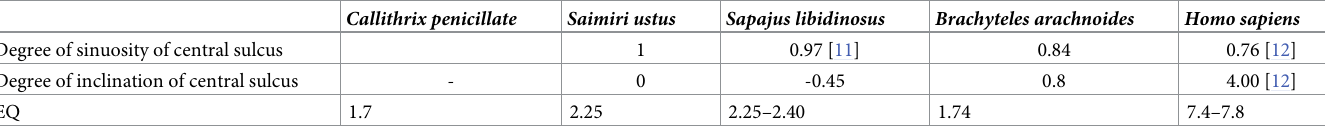
Table 7. Degree of sinuosity and degree of inclination of the central sulcus shown as the calculated Encephalization Quotient (EQ) for Callithrix penicillata , Saimiri ustus , Sapajus libidinosus , and Brachyteles arachnoides compared with the data for humans according Testut and Latarjet [13].